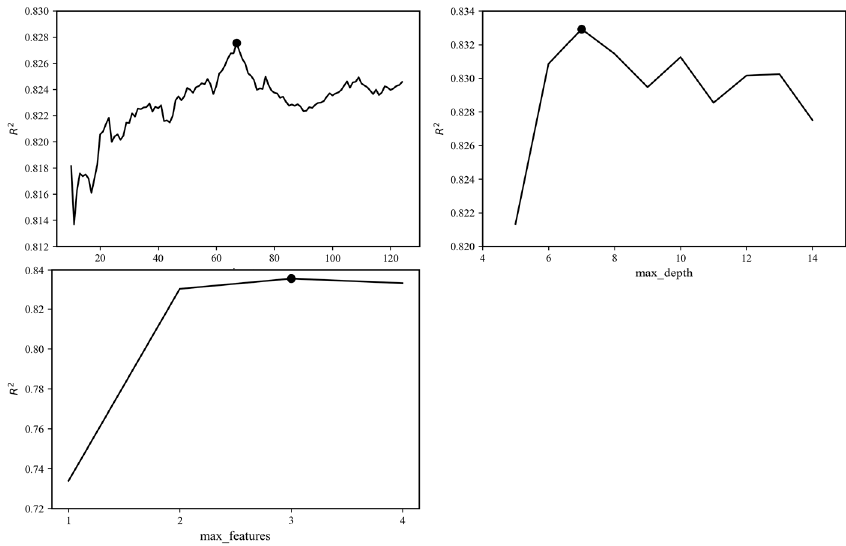
Figure 7. Determination of hyper-parameters for RF model.